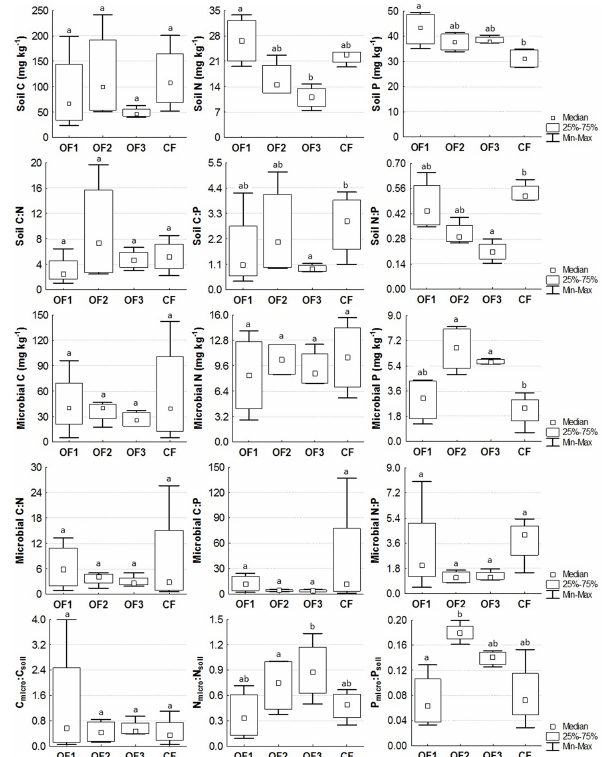
Figure 1. Carbon, nitrogen and phosphorus content of the soils and of the microbial biomass of the plots under organic (OF) and con- ventional farming (CF). Different letters indicate that differences between plots are not due to chance ( P <0.05).